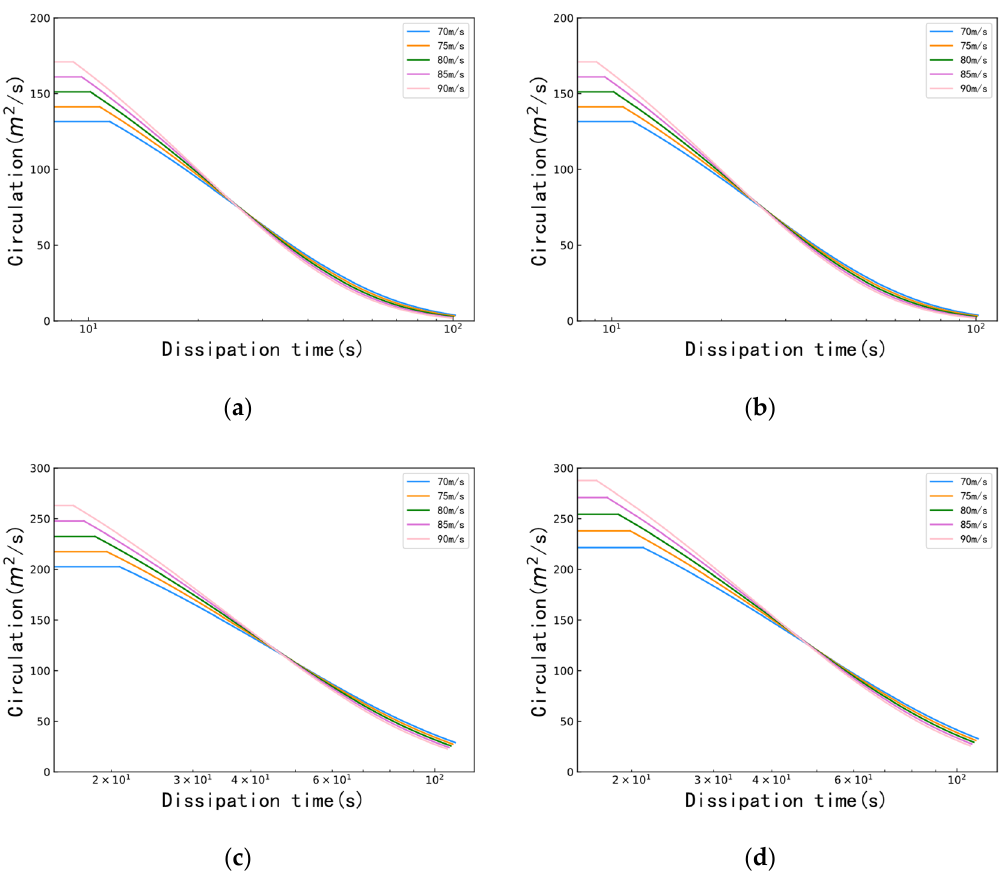
Figure 4. The wake-vortex evolution for different aircraft at different flight velocities. ( a ) A320. ( b ) B738. ( c ) B789. ( d ) A333